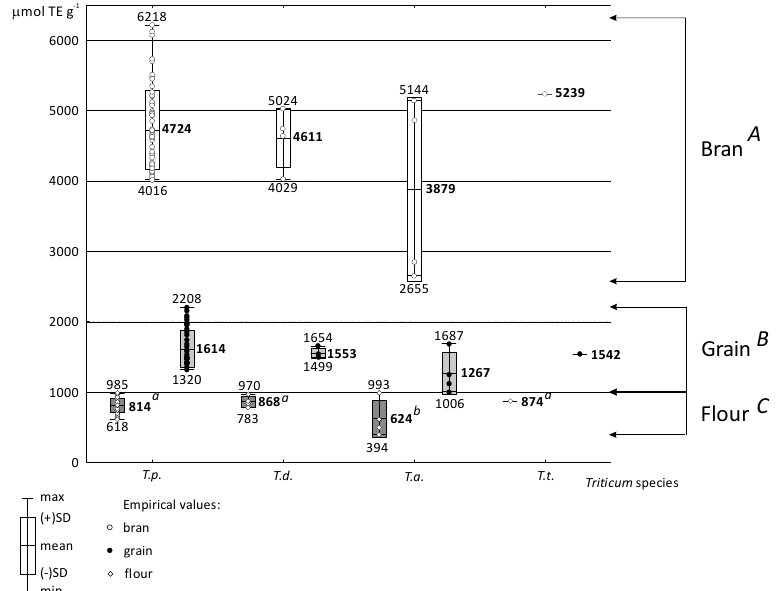
Figure 1. The antioxidant activity of the grain, bran, and flour of the analyzed accessions and cultivars of four Triticum species. T.p. — Triticum polonicum , T.a. — T. aestivum , T.d. — T. durum , T.t — T. turanicum . a,b —mean values marked with the same letters do not di ff er significantly only for flour. A–C —the mean values for bran, grain, and flour marked with di ff erent letters di ff er significantly at p <